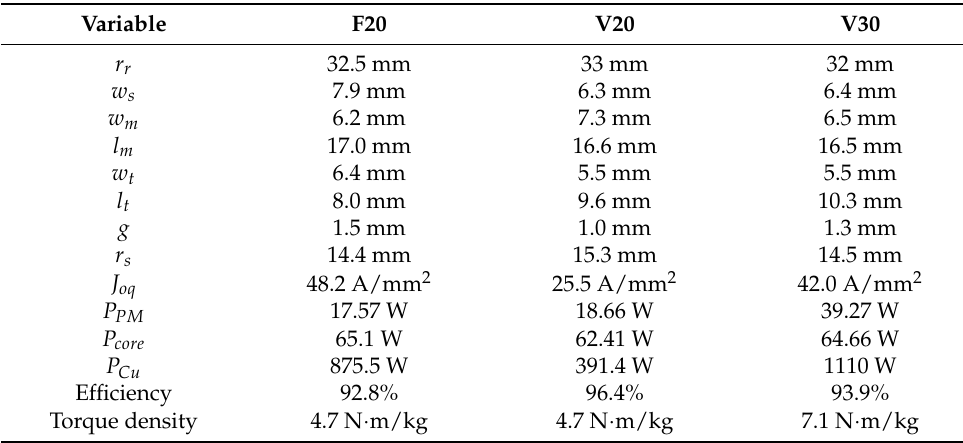
Figure 16. Selected optimized geometries: ( a ) F20, ( b ) V20, ( c ) V30. Table 3. Decision variables of selected geometries.